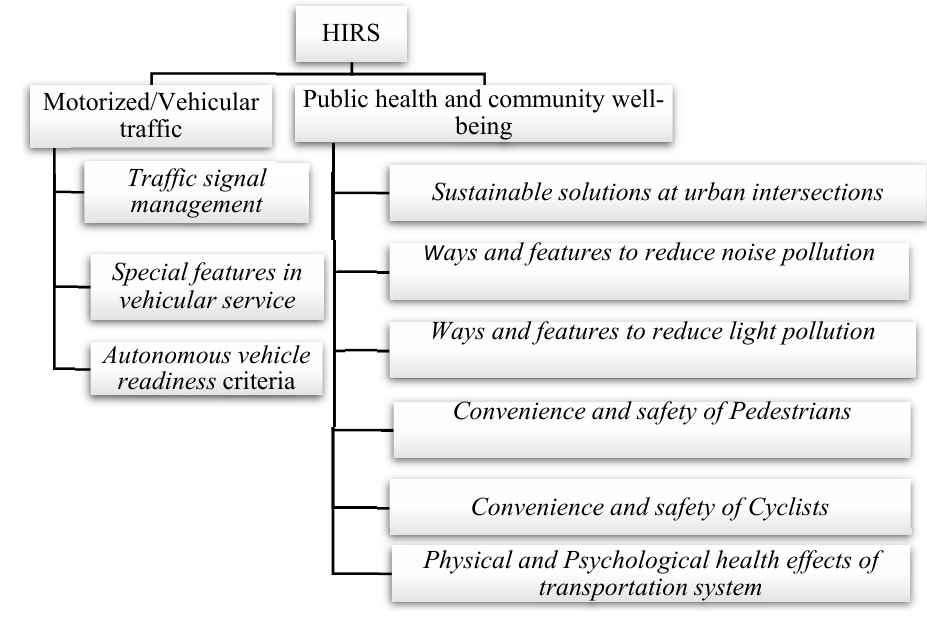
Figure 2. HIRS structure.